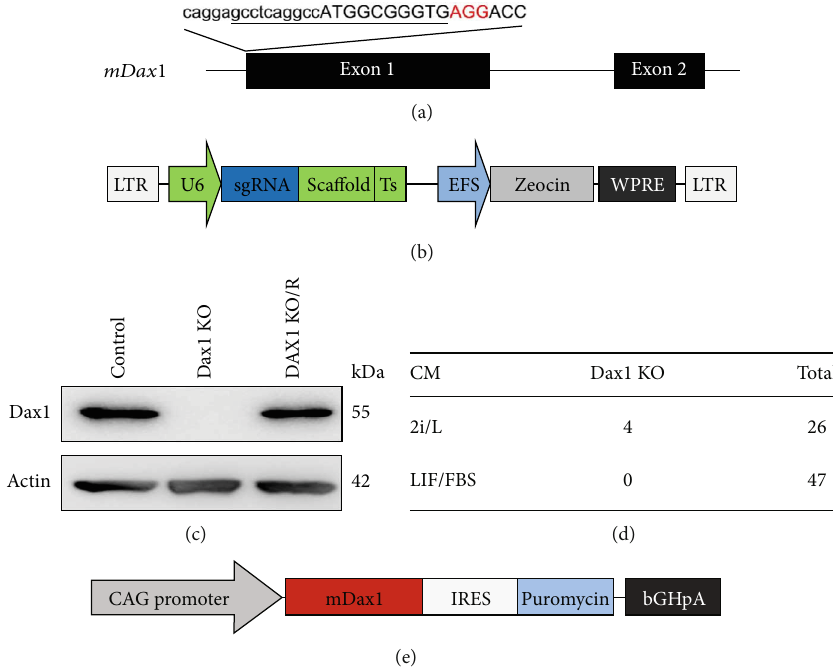
Figure 2: Establishment of Dax1KO-ESCs in 2i culture. (a) Schematic of the Cas9/sgRNA target site in the mouse Dax1 genomic locus. The sgRNA-targeting sequence is underlined, and the PAM sequences are marked in red. (b) Schematic diagram of lentivirus-based dual U6- sgRNA expression cassette constructs with the cassette of EFS-zeocin. (c) The expression of Dax1 and Actin was detected by Western blotting. (d) Dax1 cDNA was cloned into an expression vector carrying a CAG promoter and within the transcription unit linked to the puromycin resistance gene by an IRES. (e) Dax1-null colonies screened under LIF/serum and 2i